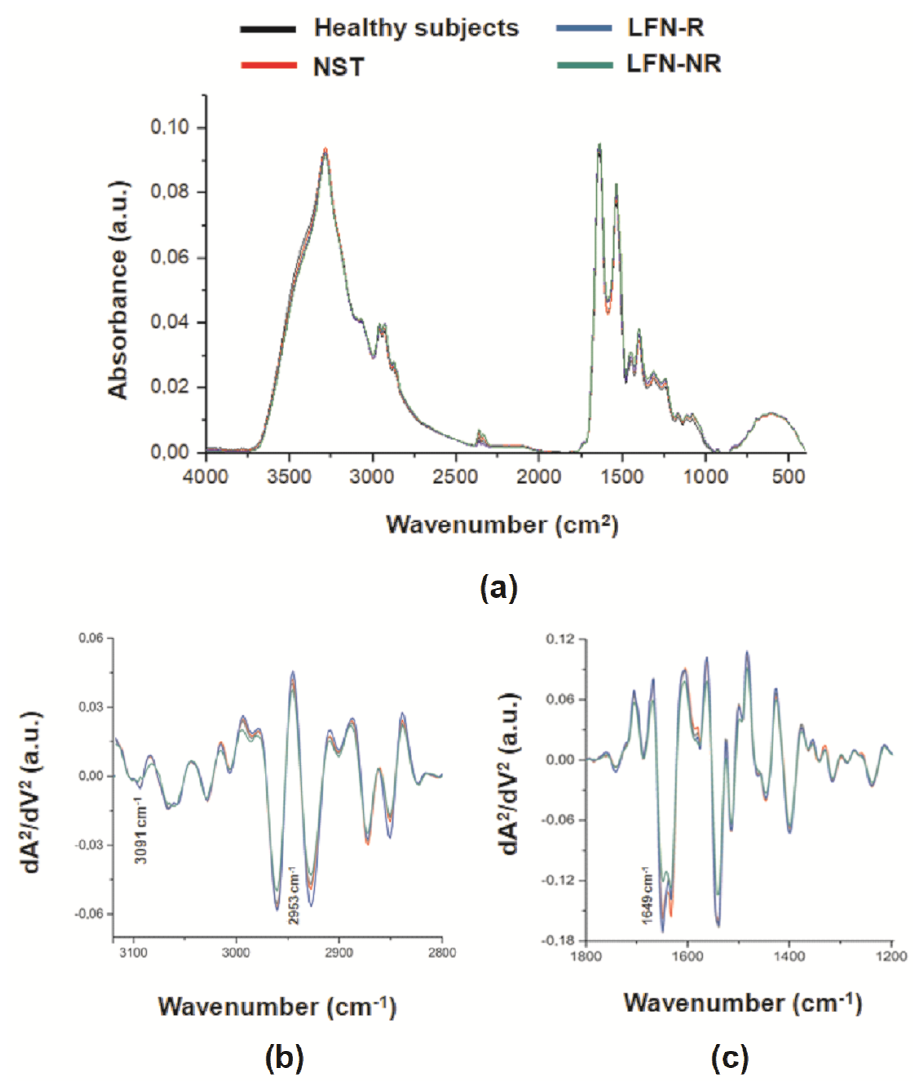
Figure 4. Representative spectral markers in plasma samples by FTIR analysis. Average of infrared spectrum ( a ) and representative spectral regions of lipids ( b ) and proteins ( c ) in plasma samples obtained from healthy subjects ( n = 10), patients recently diagnosed with rheumatoid arthritis (RA) but not yet receiving specific treatment with anti-rheumatic drugs, prior to leflunomide (LFN; 20 mg/day, per os ) treatment (NST group; n = 14). Three-months following treatment, samples were collected from both responders (LFN-R; n = 8) and non-responders (LFN-NR; n = 6) to LFN.